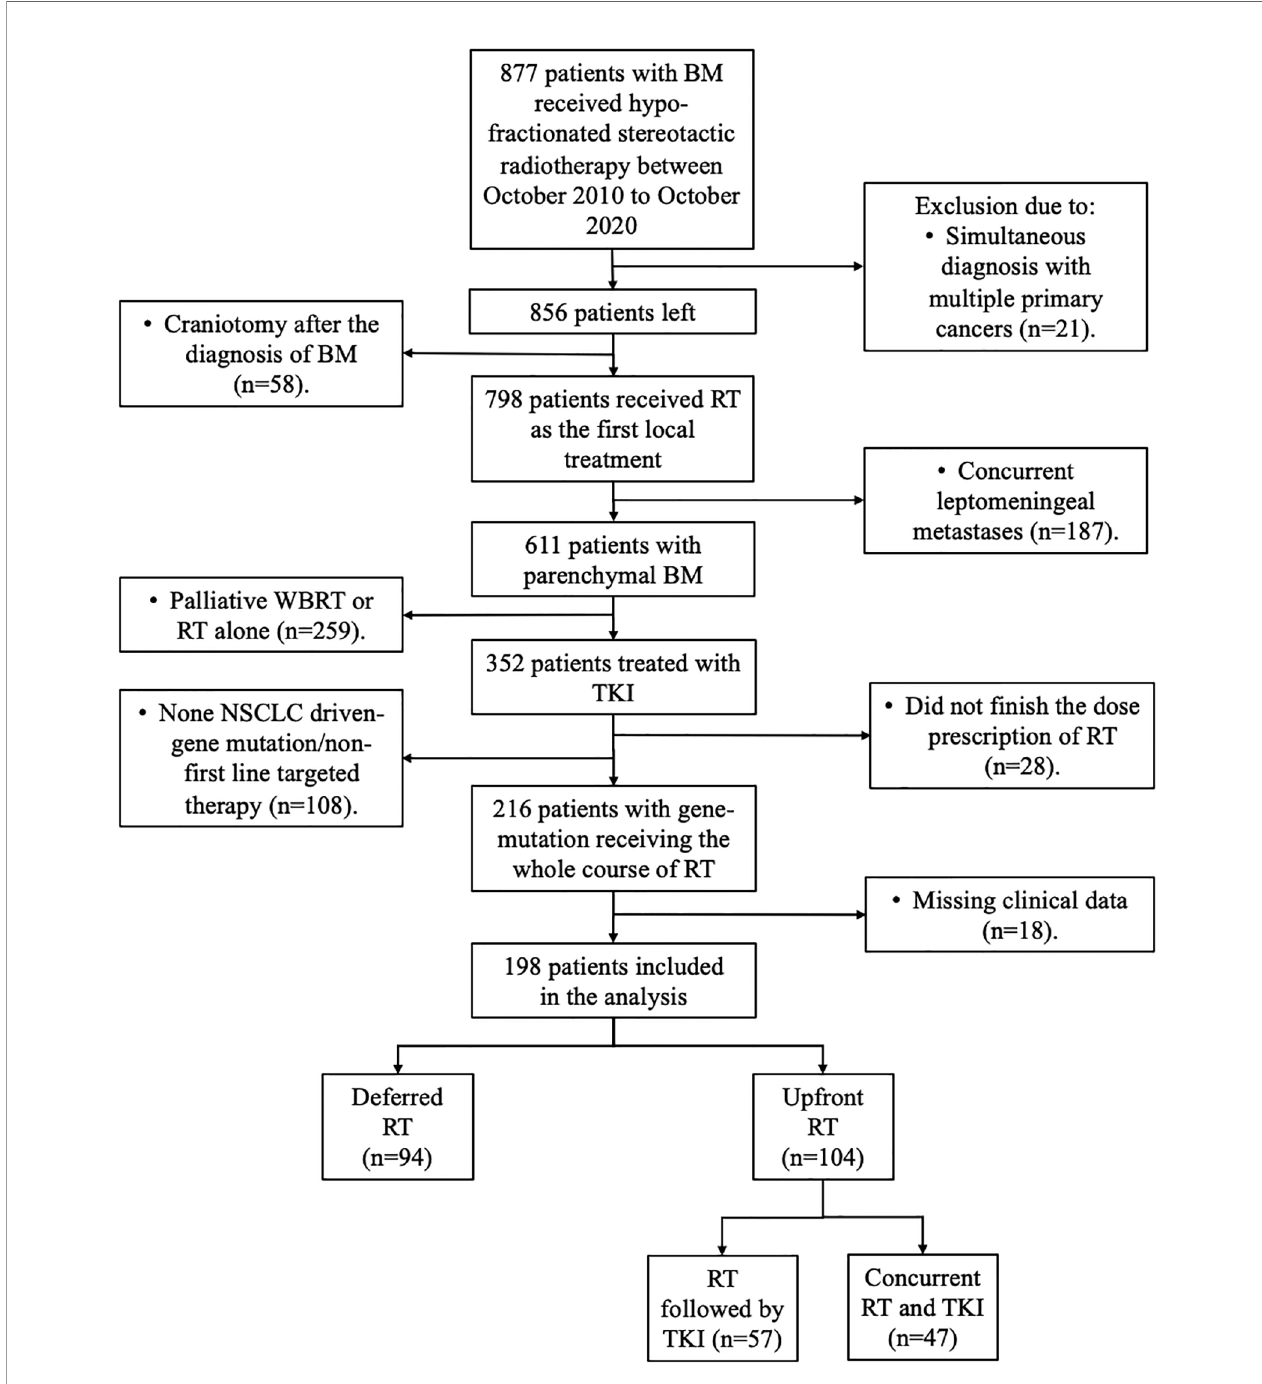
FIGURE 1 | Flow diagram showing patient